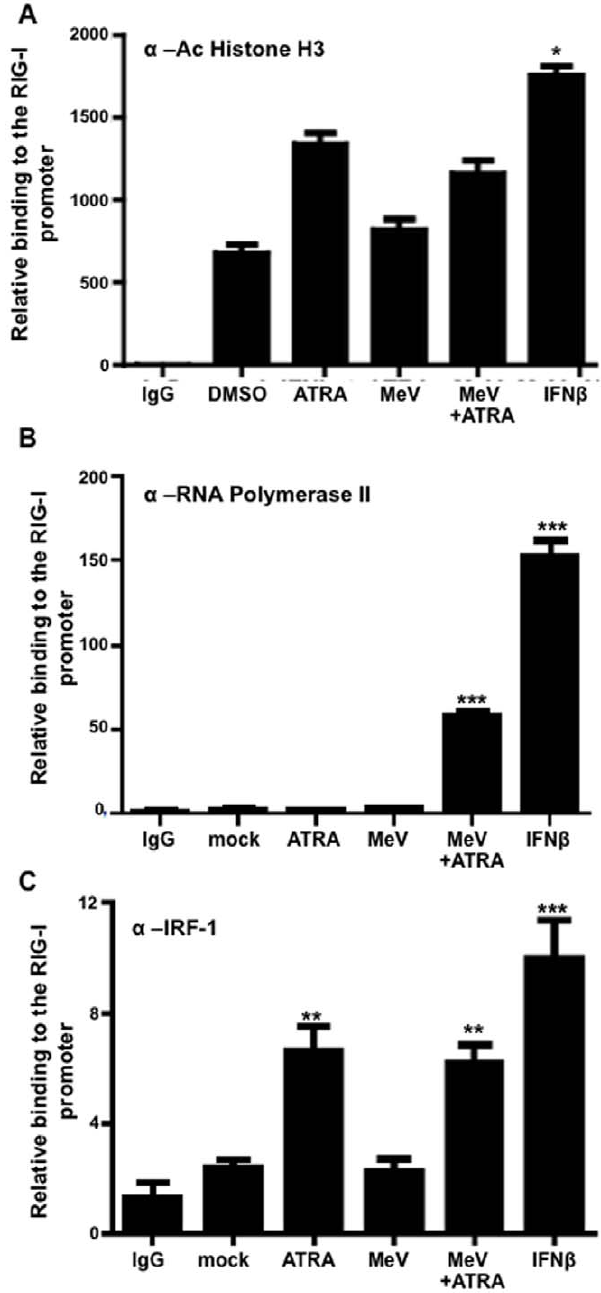
Figure 6. Activation of RIG-I promoter only upon combination of MeV infection and retinoid treatment. U937 cells were infected with MeV at an MOI of 0.1 and/or treated with 1 m M ATRA or DMSO for 24 hours. 1000 U/ml of IFN b was used as a positive control. These samples were then immunoprecipitated the following primary anti- bodies (A) Acetylate Histone H3 (B) Pol II (C) IRF-1. The pulled-down DNA was analyzed by qPCR using primers specific for the RIG-I promoter as described in the materials and methods. Data presented are representative of experiments performed in triplicate between two and three times (N=2–3). *p , 0.05, **p , 0.01, ***p , 0.001.